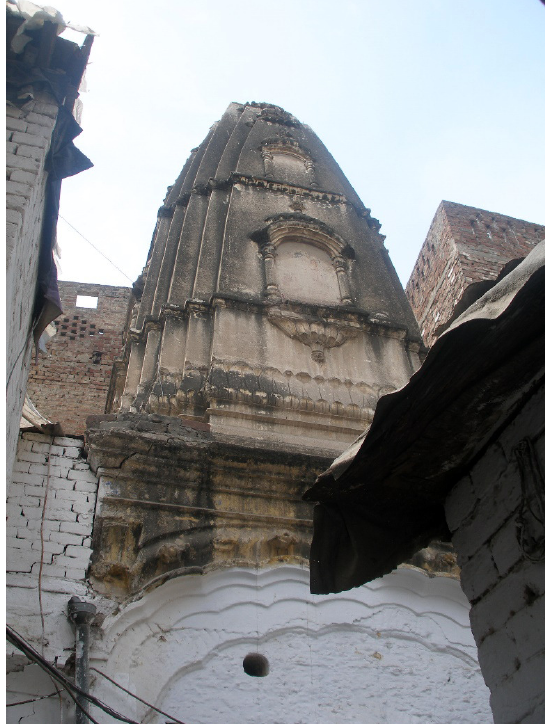
Figure 5. Remaining of Hindu temple currently used as housing. Photo by Helena Cermeño